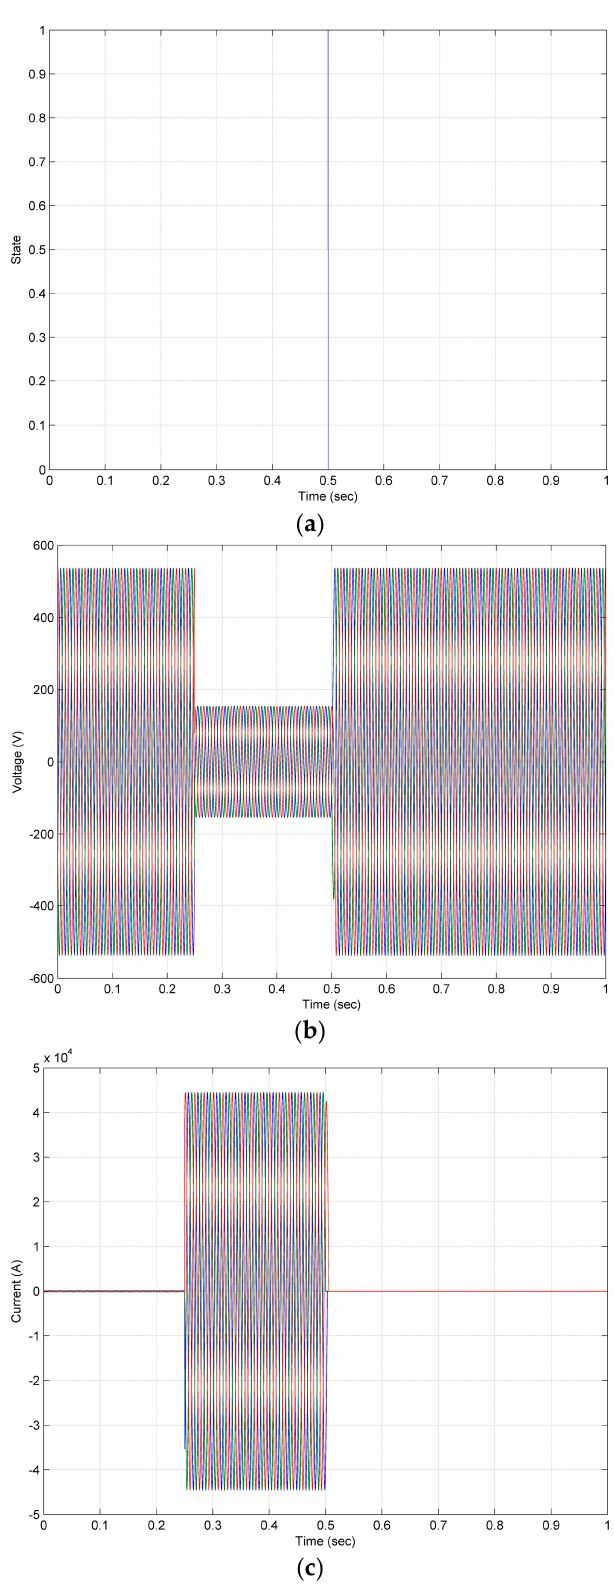
Figure 7. ( a ) CB9 CLOSE/TRIP state; ( b ) Feeder voltage waveforms of CB9 under grid-connected mode and fault occurrence at Bus 1; ( c ) Feeder current waveforms of CB9 under grid-connected mode and fault occurrence at Bus 1.